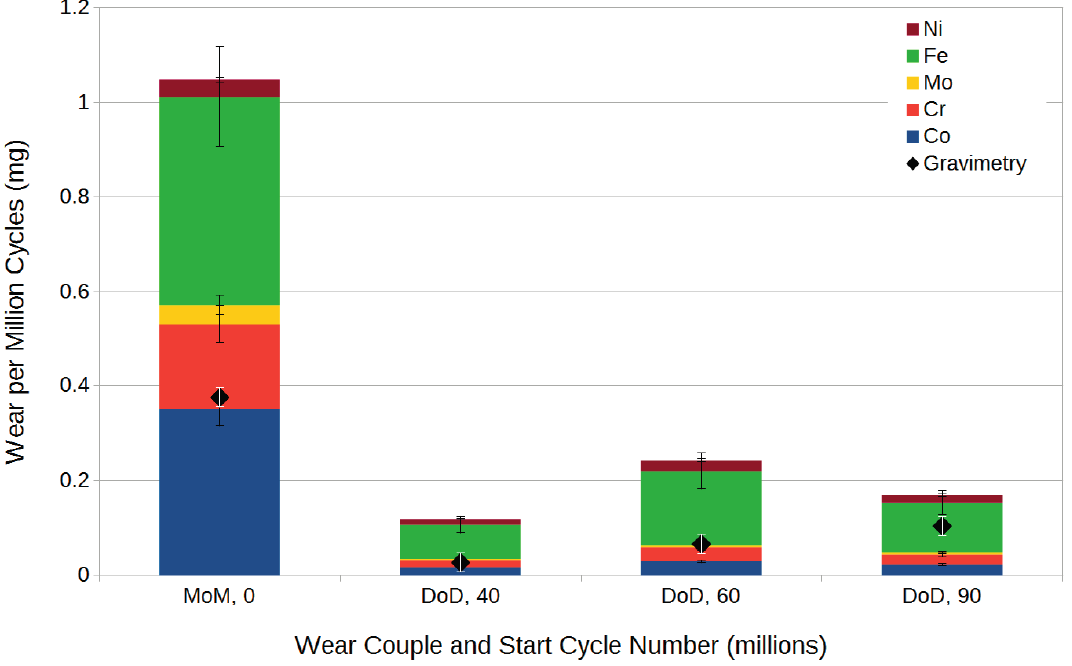
2. ICP-OES (inductively coupled plasma optical emission spectrometry) measurement results for the testing fluid in comparison to the gravimetry